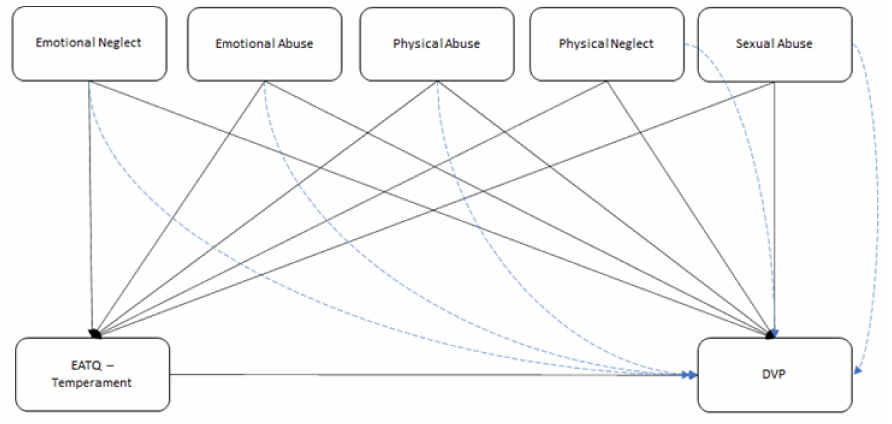
Figure 1. Statistical mediation